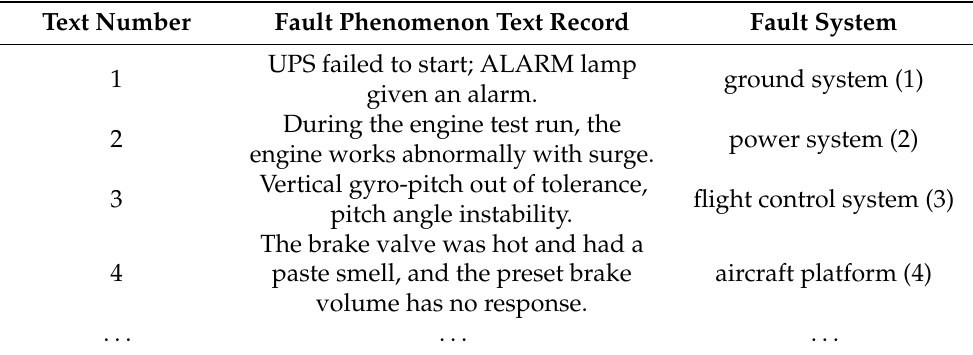
Table 2. Examples of fault phenomenon recording text data.